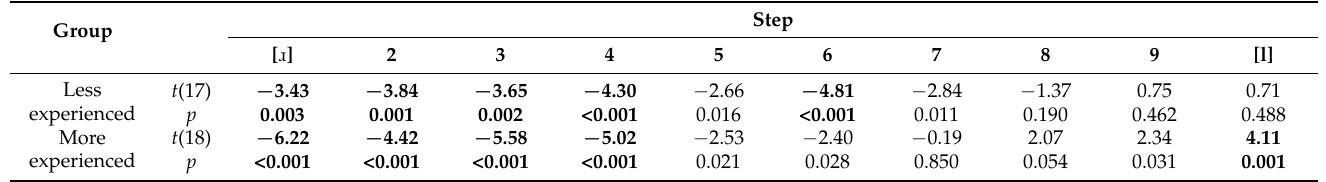
Table 1. Post-hoc paired t -tests for ratings as /r/ versus /l/ at each continuum step, for less experienced and more experienced Japanese